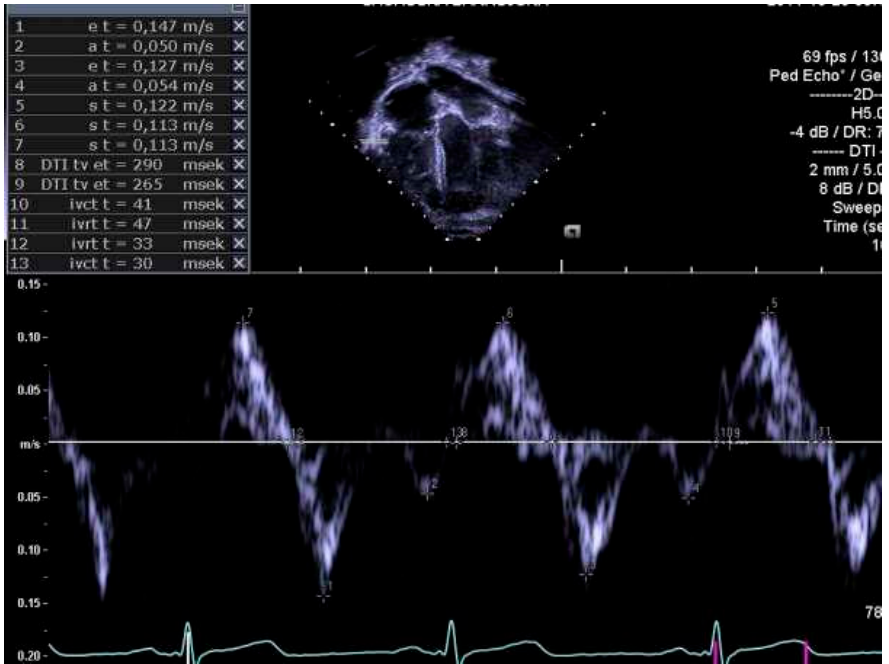
Figure 4. Right ventricular myocardial performance index (RVmpi’) assessed by pulsed wave tis- sue Doppler of right ventricular free wall.